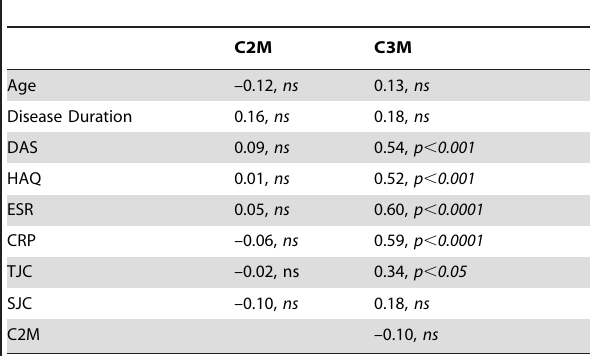
Table 3. Univariate analysis for C2M and C3M associations with age, disease duration and RA clinical characteristics; Disease activity score (DAS), health assessment questionnaire (HAQ), erythrocyte sedimentation rate (ESR), high sensitive C- reactive protein (CRP), tender joint count (TJC) and swollen joint count (SJC).